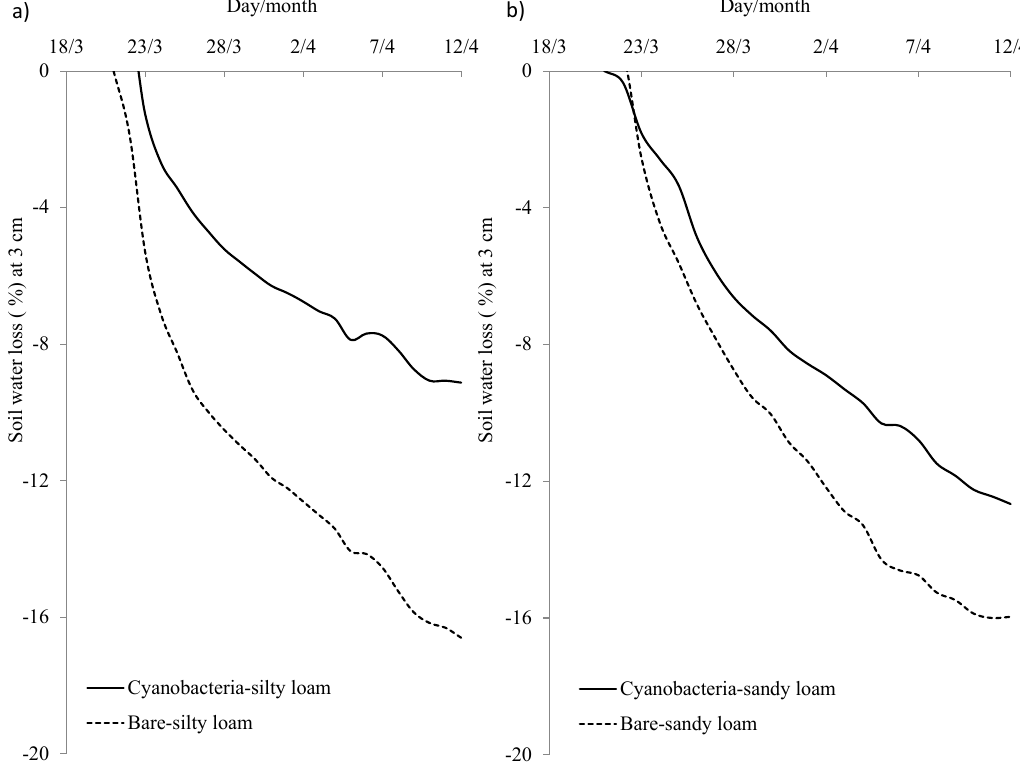
Figure 6. Violin plots showing the distribution of the slope of the drying curves fitted to a linear regression for different soil drying events at ( a ) El Cautivo and ( b ) Las Amoladeras.